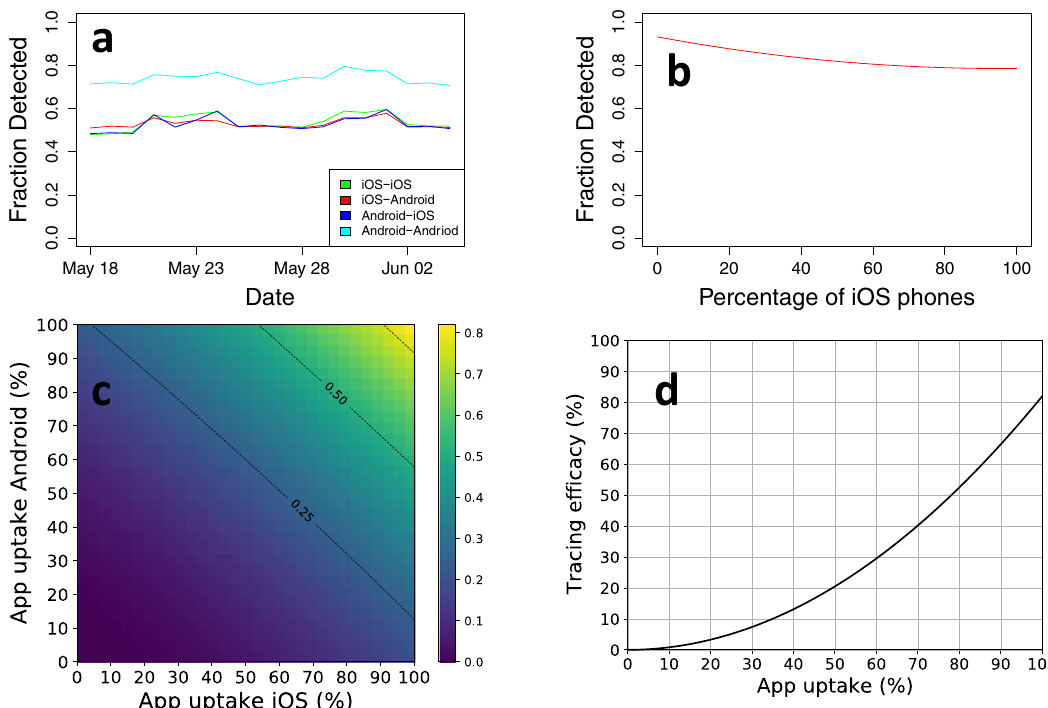
Fig. 2 The technological ef fi cacy of Smittestopp. a The probabilities of detection between different pairs of architectures as it developed over a period of 18 days, b The detection of contacts varies between 93% with only Android phones in the population to 79% with only iOS phones in the population. The detection rate is 80% when we have an equal split, c The ef fi cacy of tracing as a function of app uptake in the two user groups. The lines mark ef fi cacies of 25%, 50%, and 75%, respectively, d Tracing ef fi cacy as a function of app uptake, assuming the same uptake in the two groups as well as an equal market share ϕ ¼ 0 :